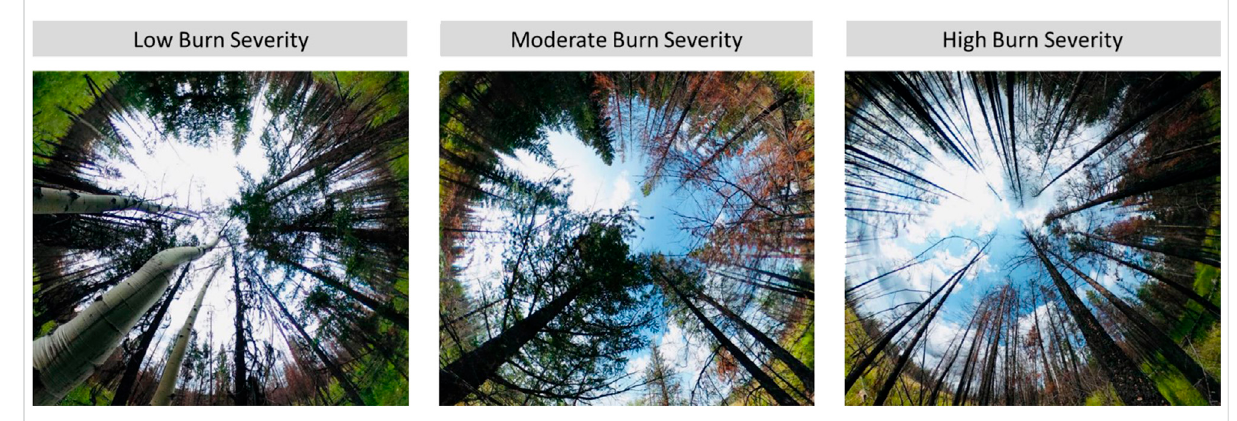
FIGURE 2 The fi sh-eye lens views of three post- fi re study sites across the burn-severity